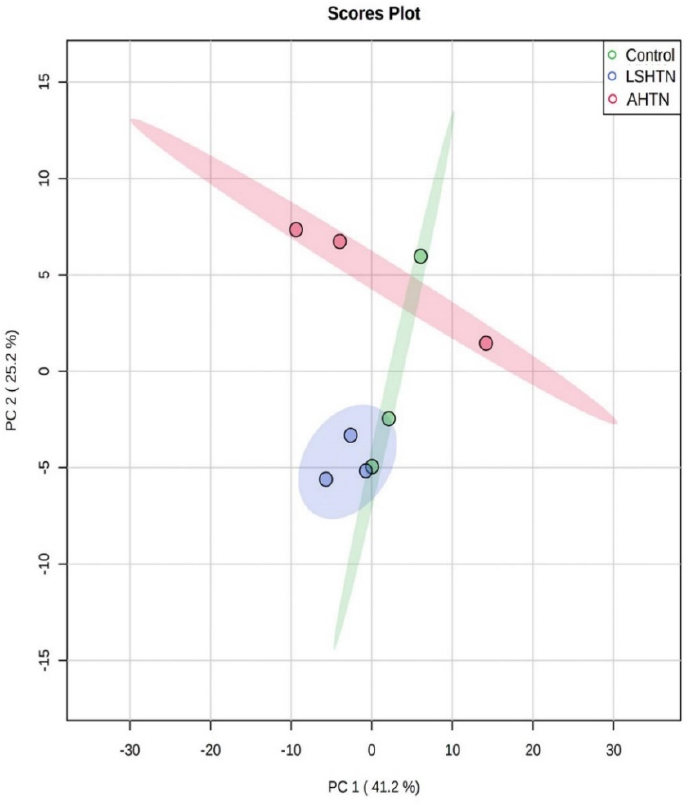
Figure 4. Metabolomics data of urine showing intermixed results of the hypertensive groups with the control group. PCA plot of metabolites present in the urine based on untargeted metabolomics demonstrated no visible segregation among metabolites of LSHTN and AHTN mice when compared to control mice, ( n = 3).